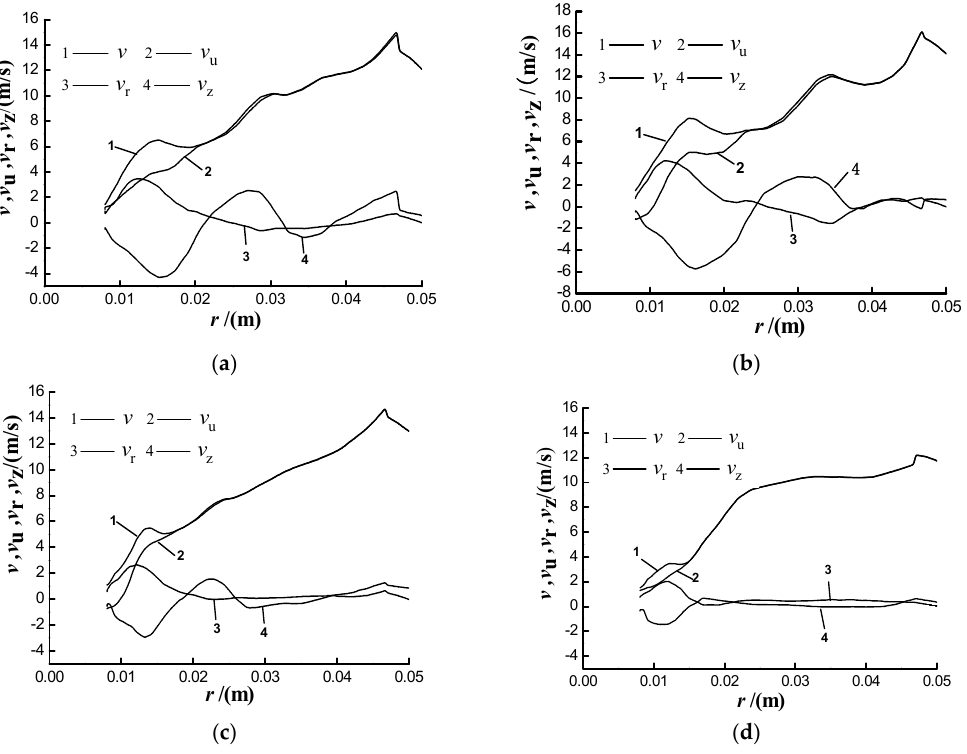
Figure 9. Velocity variable curves for the axial cross-section Z = − 10 mm along the radial direction. ( a ) 0°; ( b ) 90°; ( c ) 180°; ( d ) 270°.